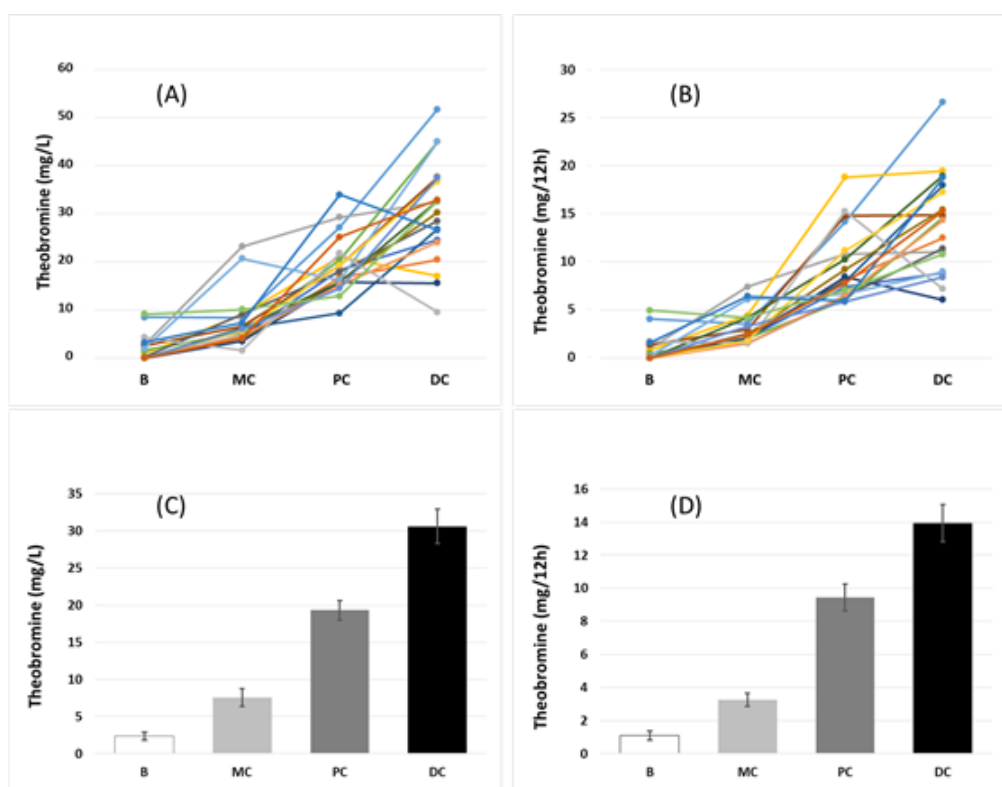
Figure 2. Effect of the consumption of different cocoa products on urinary theobromine concentration ( A ) and total theobromine excretion in 12 h ( B ) in each of the 20 volunteers (each colored line corresponds to one of the volunteers), and mean concentration ( C ) and total excretion in 12 h ( D ) among all 20 volunteers. An ANOVA repeated measures test indicated significant differences among the four groups in concentration and excretion ( p < 0.05). B: basal, MC: milk chocolate, PC: chocolate powder, and DC: dark